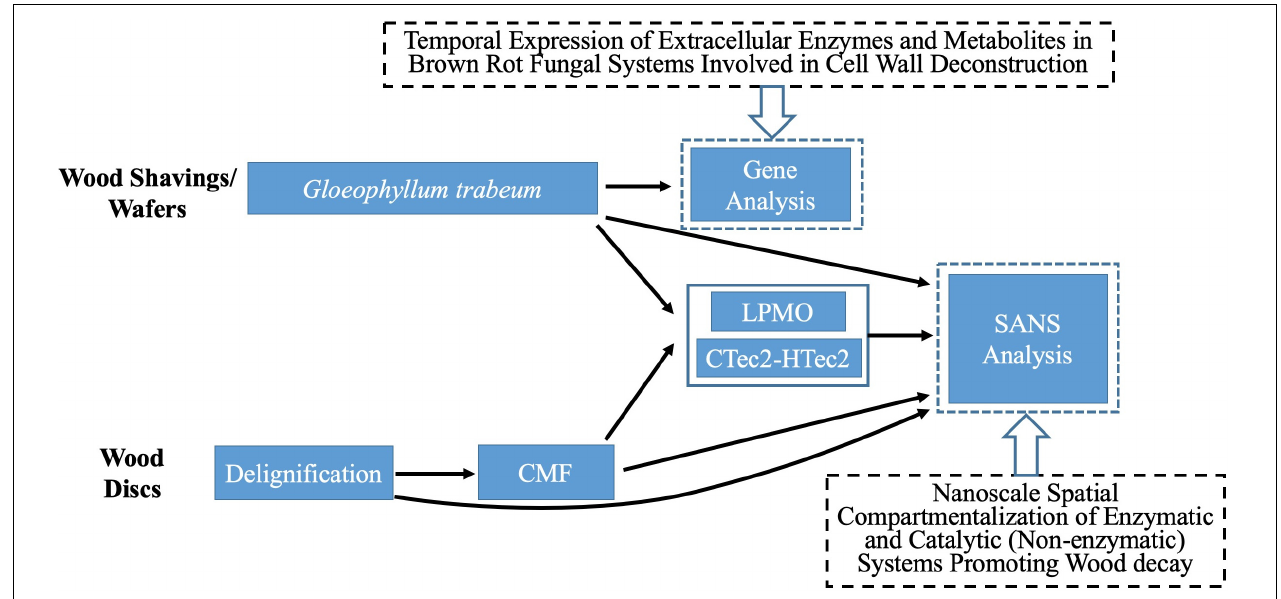
FIGURE 1 | Flow chart of materials, treatments and analyses used in our procedures.